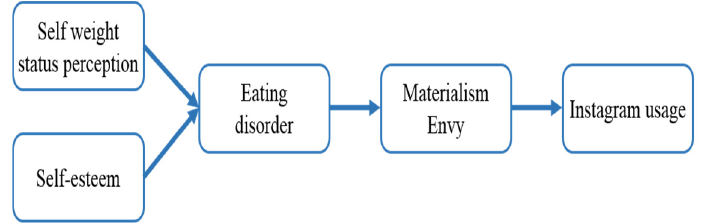
Figure 2. Study 2: Conceptual